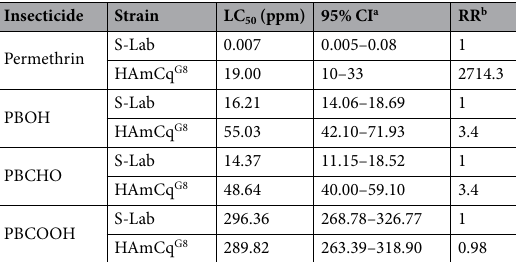
Table 2. Toxicity of Permethrin, PBOH, PBCHO and PBCOOH to the larvae of Culex quinquefasciatus . a 95% confidence interval; toxicity of insecticide is considered significantly different when the 95% CI fail to overlap. b RR: